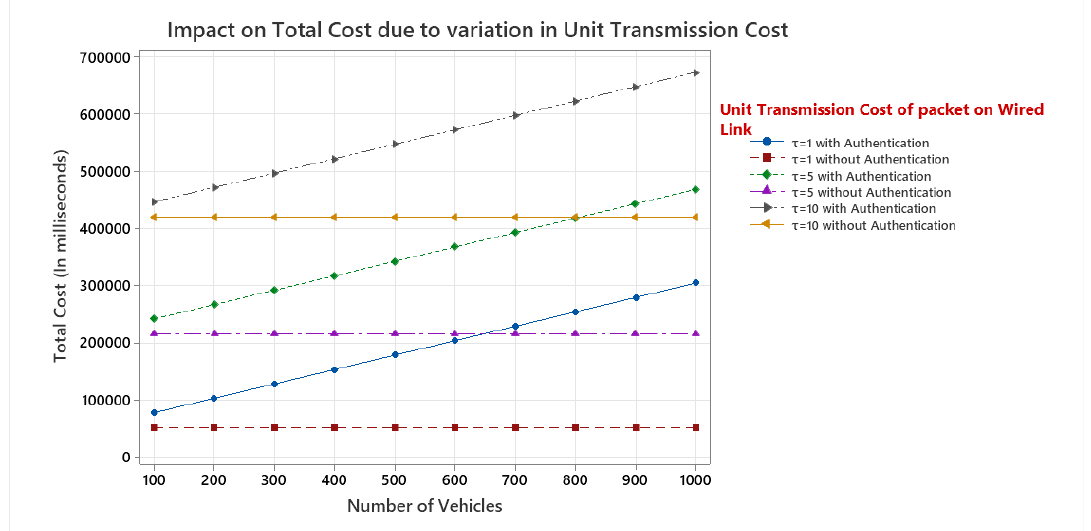
Figure 8. Impact on total cost due to variation in unit transmission cost.